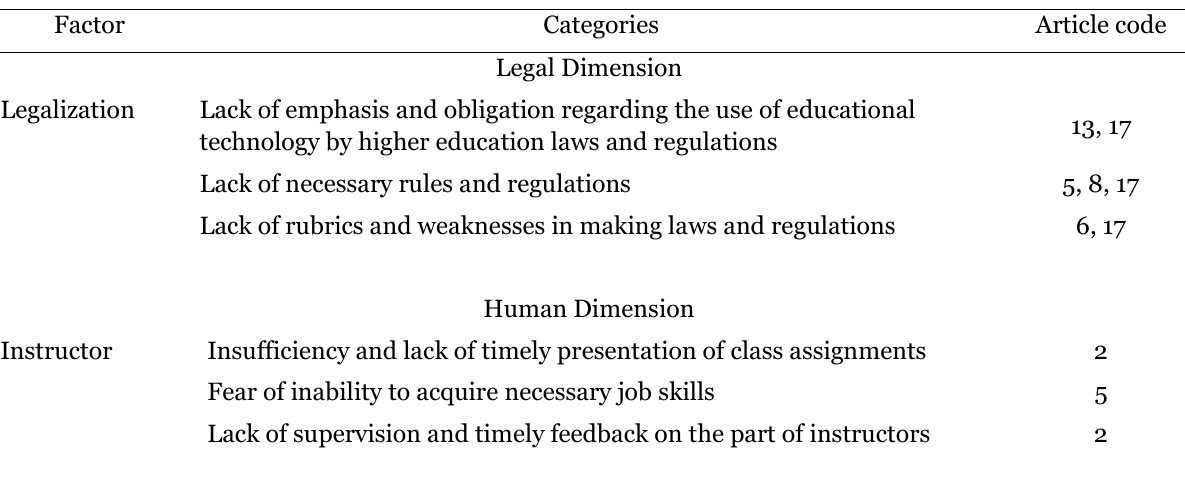
Classification of Thematic Categories Derived From Coding and Their Source Articles